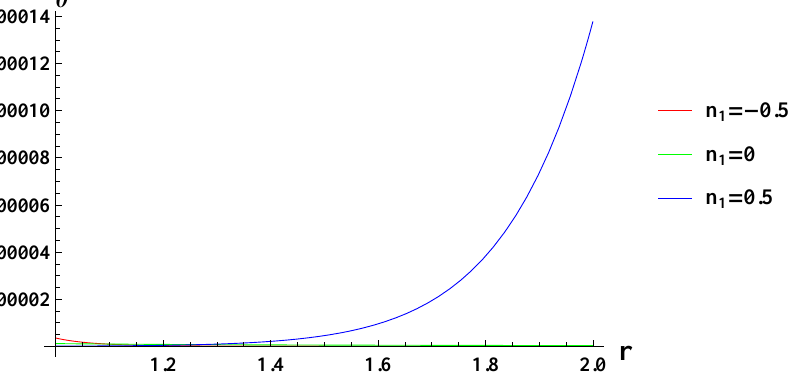
Figure 6. Tangential strain rate along the radius r (in cm) of the cylinder, under the effect of rotation ( ω 2 = 50 rad/s), internal pressure p i = 50 MPa and exponential volume reinforcement.